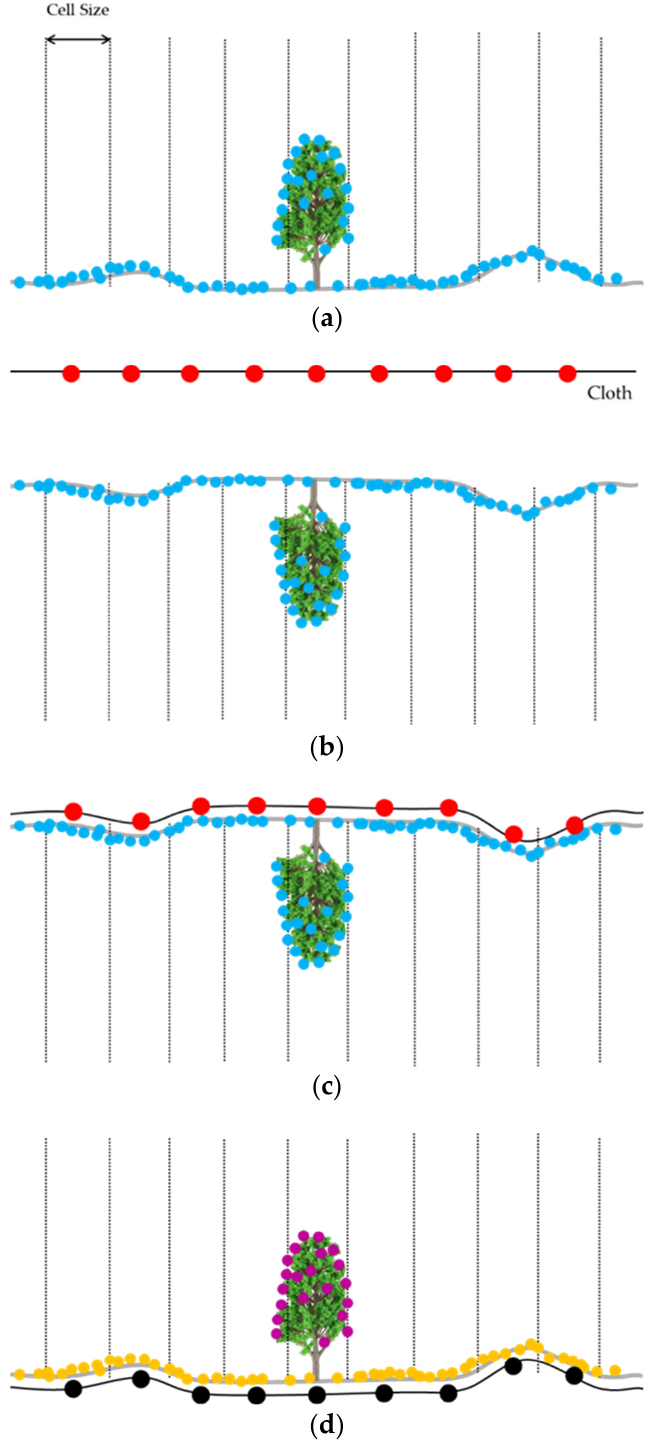
Figure 11. Schematic diagram of the cloth simulation strategy: ( a ) LiDAR points covering an area with a tree; ( b ) inverted LiDAR points and initial cloth; ( c ) final cloth; and ( d ) derived DTM as well as bare-earth and above-ground points.